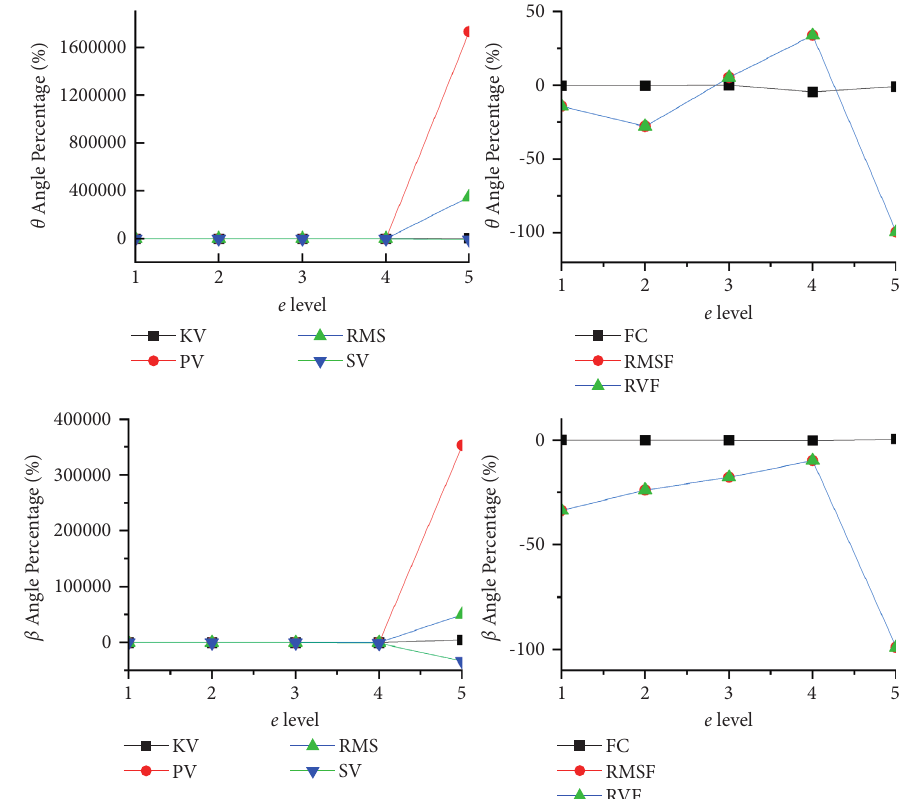
Figure 8: Effect of the lifting acceleration on the lift-luffing